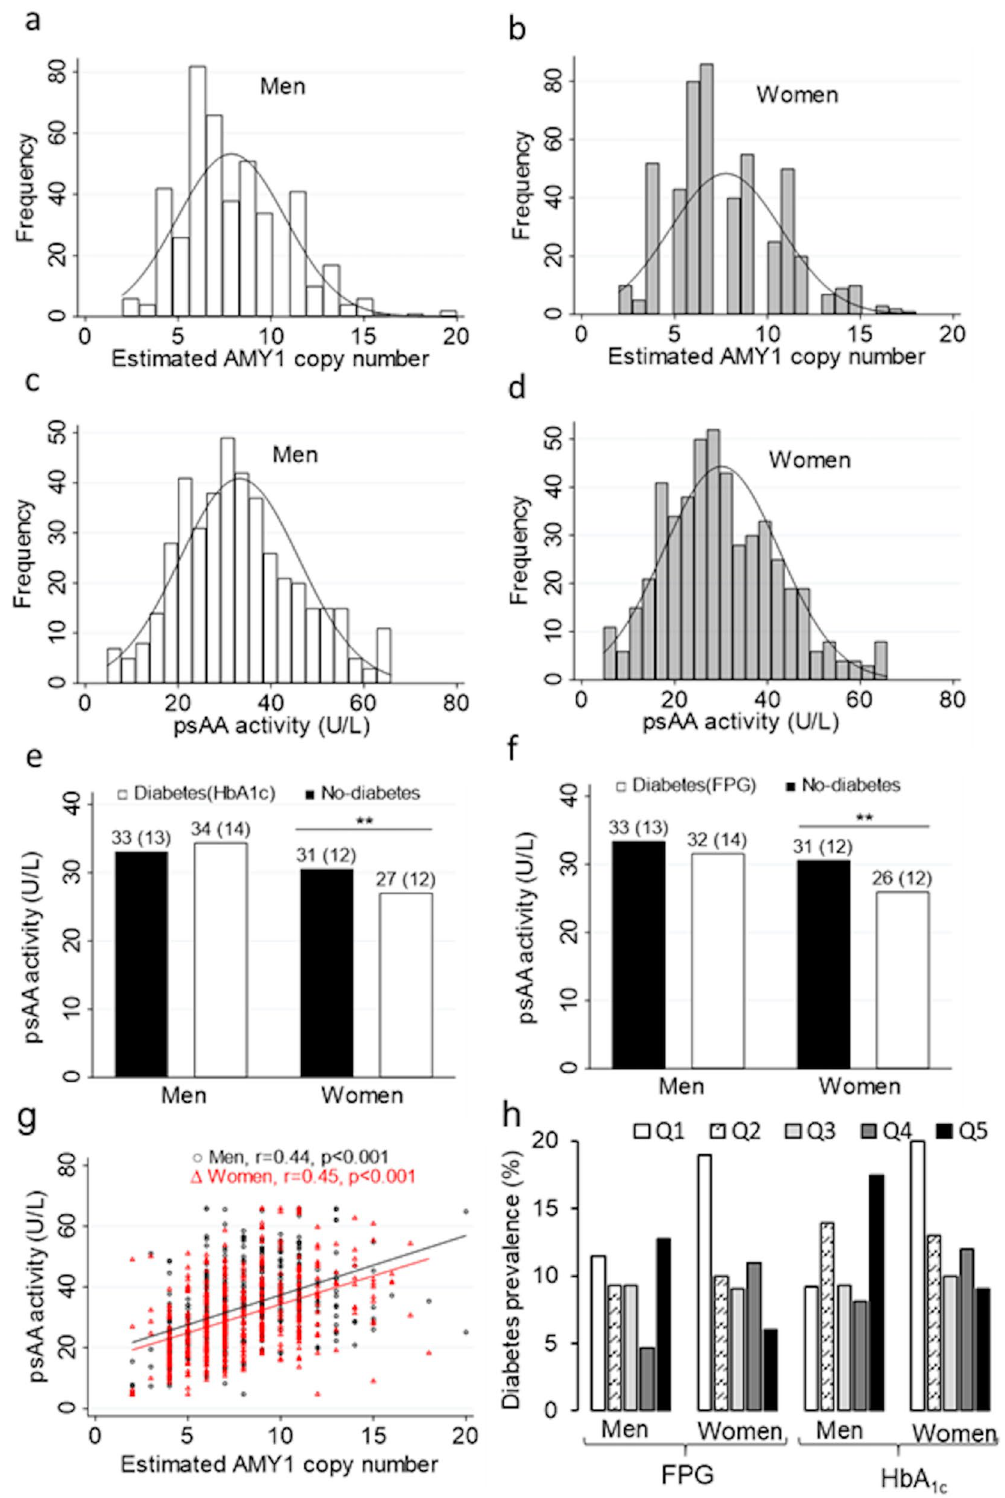
Figure 1. Distribution by gender of AMY1 CN ( a,b ), and pSAA activity ( c,d ). Comparison of mean pSAA activity in women and men with and without diabetes ( e,f ). Correlation between AMY1 CN and pSAA activity in men (black circles) and women (red triangles) ( g ) the straight lines represent the line of best fit for men (black) and women (red). Prevalence of diabetes by quintiles of pSAA activity ( h ). Data in ( e,f ) are mean ± SD. *And **significant at p < 5% and p < 1%,